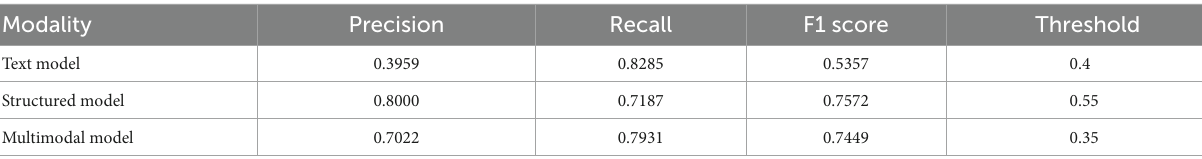
TABLE 3 Performance metrics.